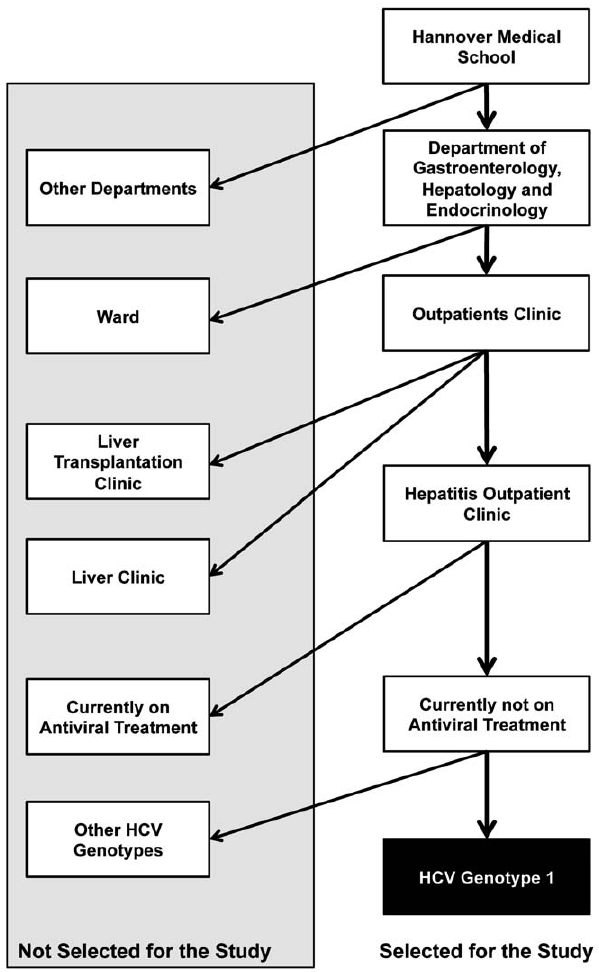
Figure 1. Selection of the study cohort.